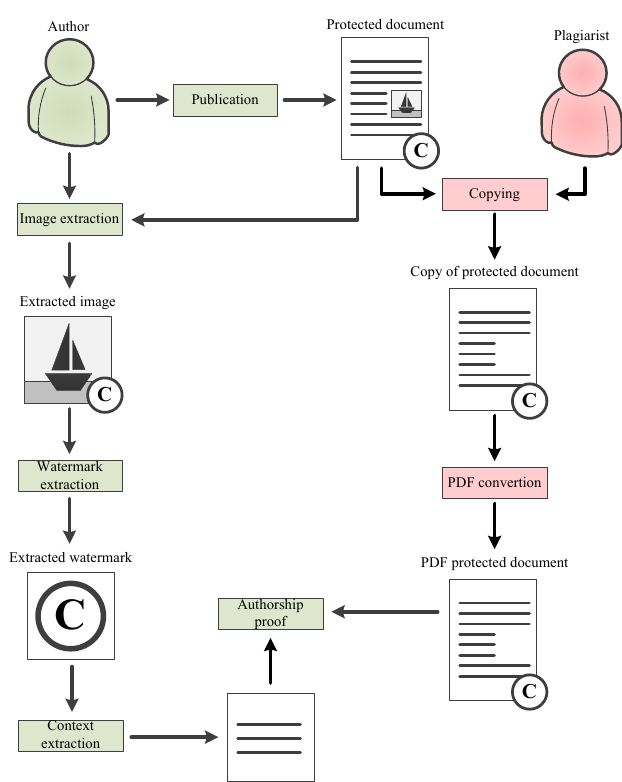
Figure 5. Authorship proof scenario when copying text only.